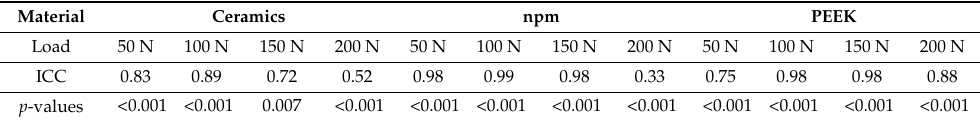
Table 3. p -values of the equivalence tests and intraclass correlation coefficients (ICC) for the optical measurement method and strain gauge